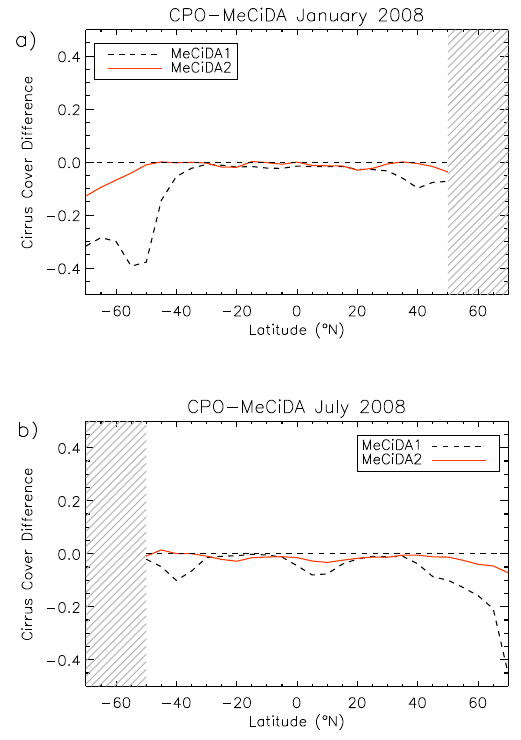
Fig. 11. Difference in mean cirrus cloud cover during Jan- uary 2008 (a) and July 2008 (b) over the selected region between MeCiDA on SEVIRI and CPO on MODIS before (dashed line) and after (solid line) the enhancements. This comparison was only car- ried out for daylight granules, due to the usage of solar channels by the CPO product (hatched area